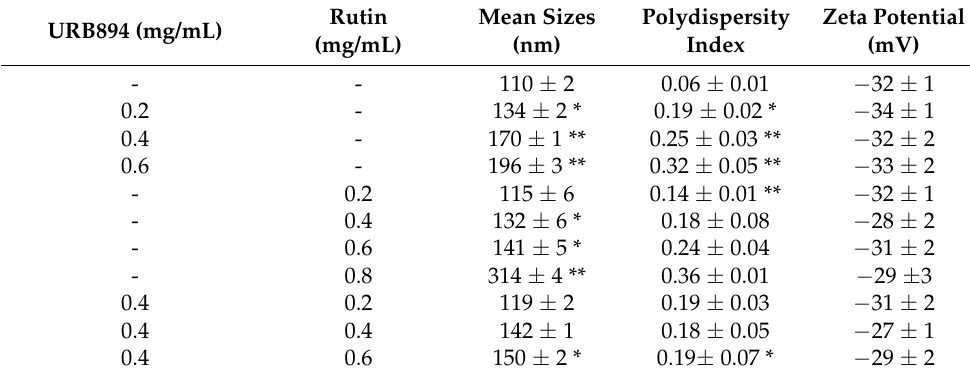
Table 1. Physicochemical properties of PLGA nanoparticles as a function of the amounts of active compound(s) used during their